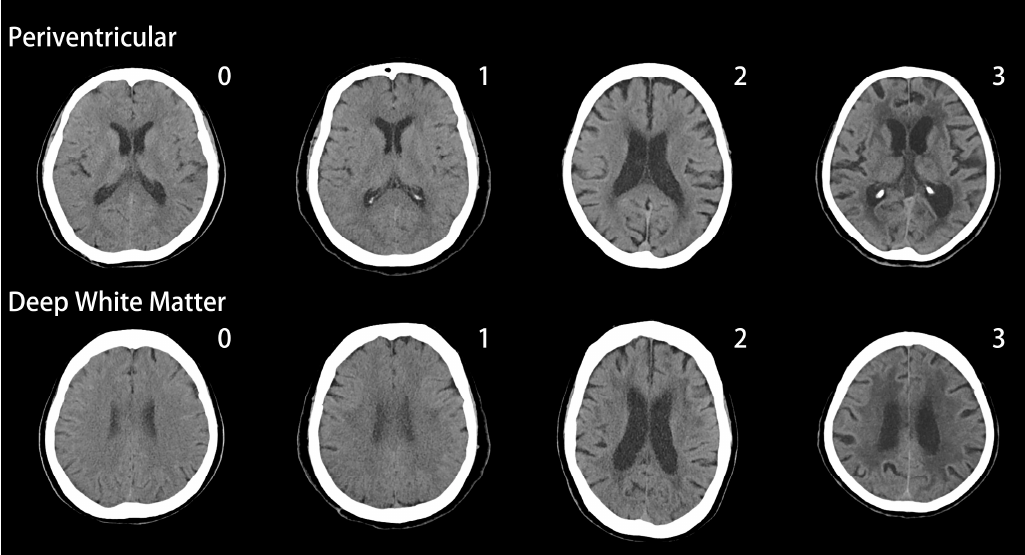
140 Figure 1. White matter changes (WMCs) in AD patients, Fazekas scale. Figure 1. White matter changes (WMCs) in AD patients, Fazekas